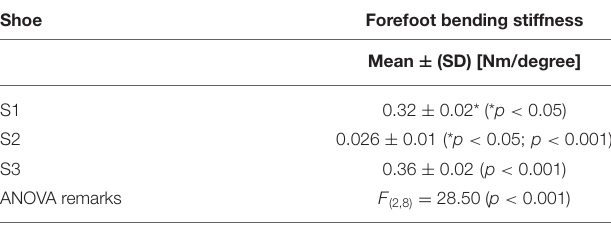
TABLE 2 | The mean forefoot bending stiffness of each shoe. Shoe Forefoot bending